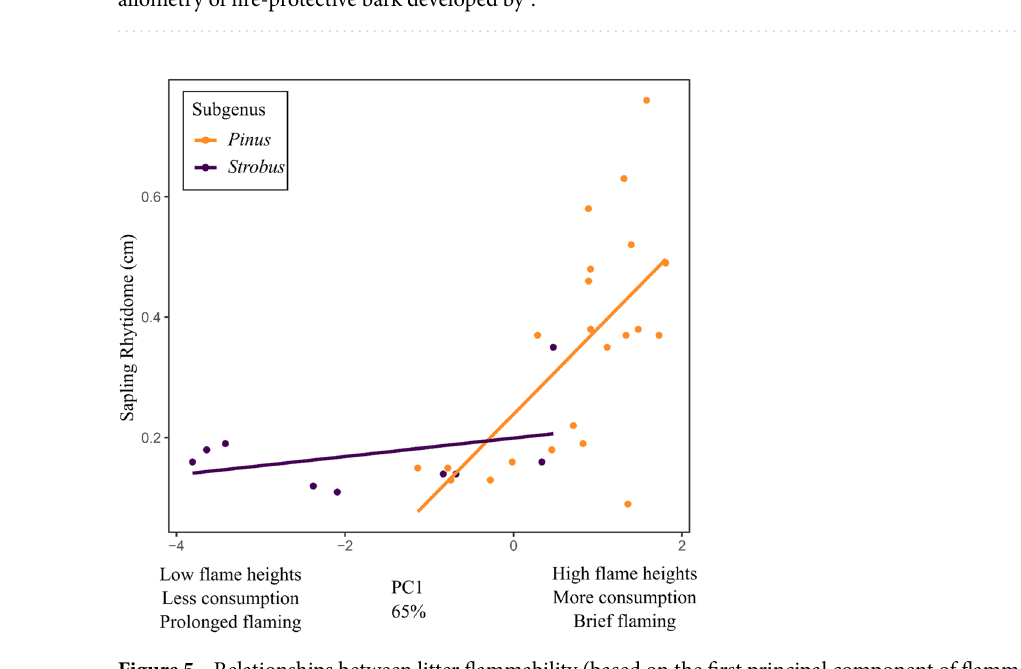
Figure 4. Phylogeny of 31 Pinus species in North America examined in this study. The left tree is colored to indicate litter flammability based on the first principal component axis. The right tree is colored based on the allometry of fire-protective bark developed by 7 .